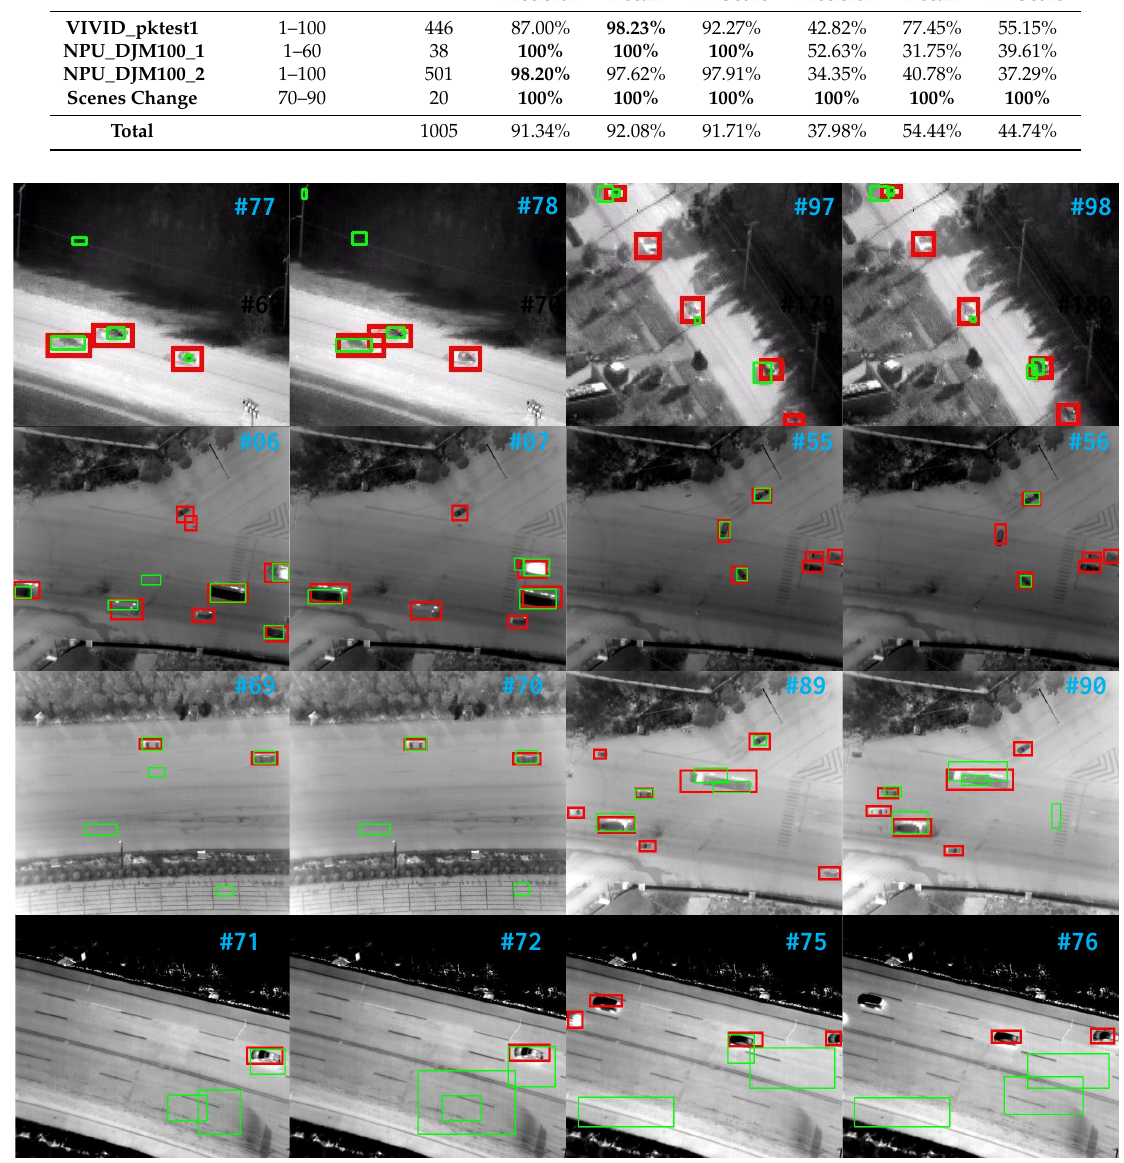
Figure 10. Comparison with a state-of-the-art method in [18]. The red rectangle is the proposed method’s detection results, the green rectangles belong to [18]. From top to bottom: